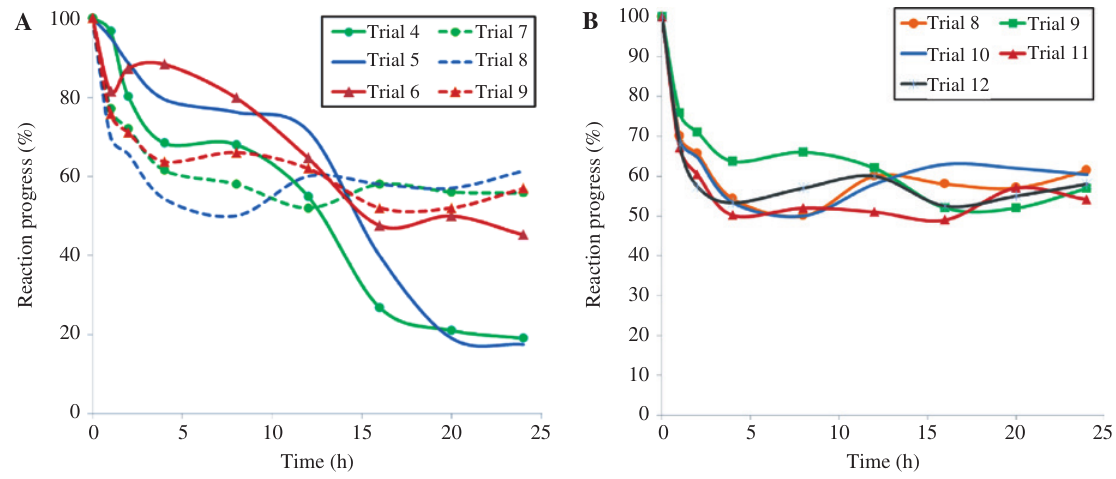
Figure 5: (A) The comparison of trials 4–6 and 7–9, at similar conditions but at elevated and room temperature, respectively. (B) Trials under similar reaction but different catalysis